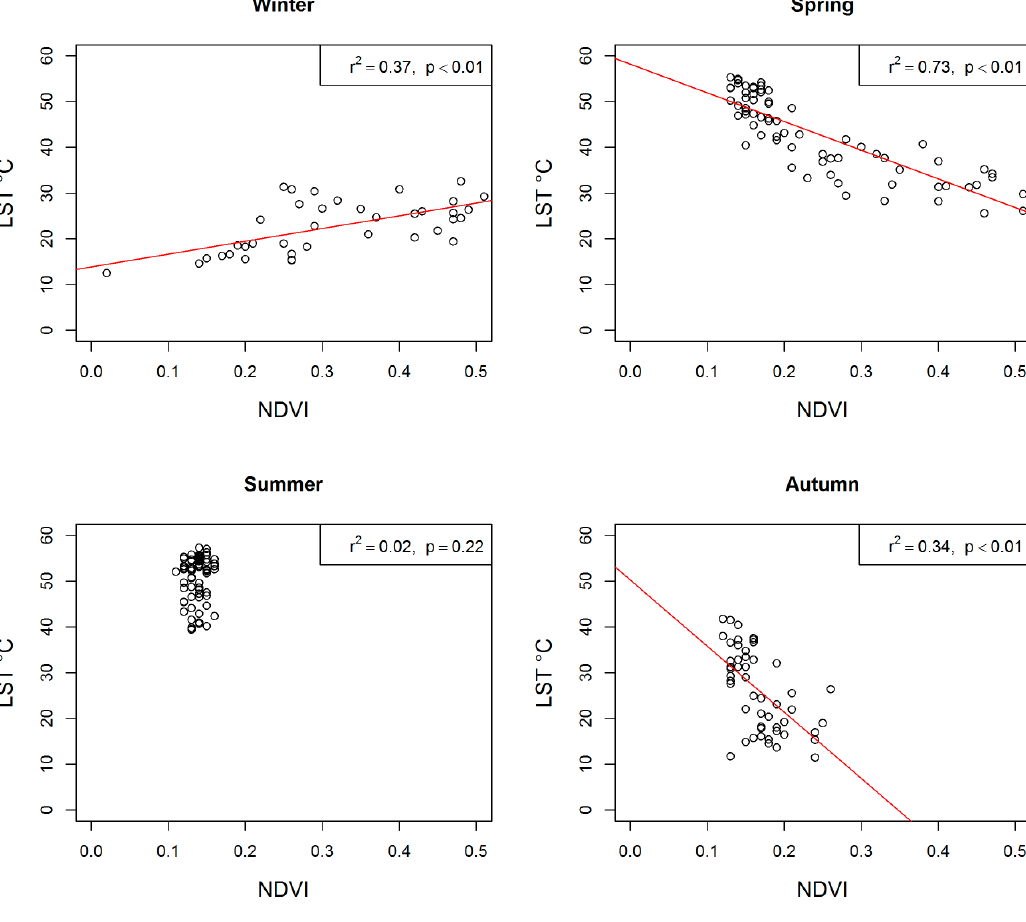
Figure 7. Land Surface Temperature vs. Seasonal NDVI, from 12 years MODIS data.